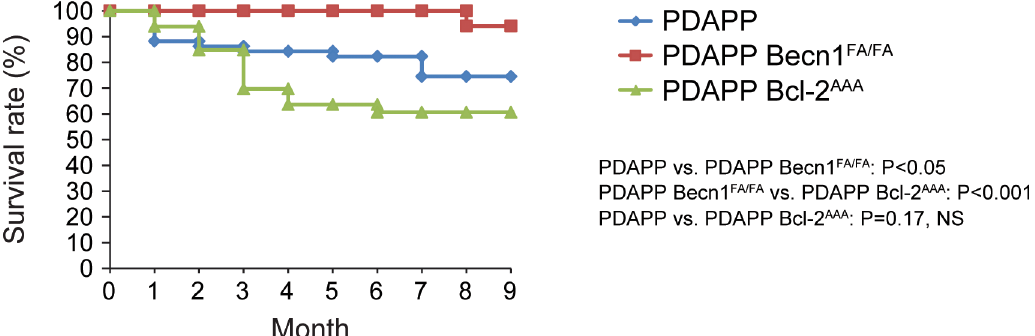
Fig 4. Becn1 F121A improves the survival rate of PDAPP AD mice. Kaplan-Meier survival curve of PDAPP mice with normal (PDAPP, N = 51), hyperactive(PDAPP Becn1 FA/FA , N = 34), or deficient(PDAPP Bcl2 AAA , N = 33) autophagy monitored over time for 9 months. Statistical significancewas analyzedby the